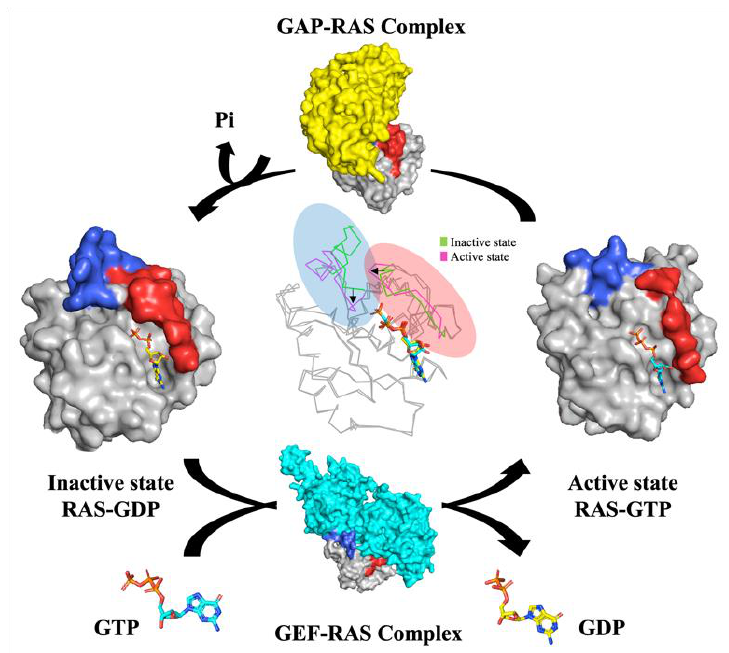
Figure 2. RAS cycles between ‘ i nactive’ state bound to GDP and ‘ a ctive’ state bound to GTP. RAS acts as a guanosine diphosphate (GDP)-inactive molecular switch in resting cells and becomes acti- vated in response to extracellular receptors by binding guanosine triphosphate (GTP), as catalyzed by the guanine nucleotide exchange factor (GEF). The GTPase-activating protein (GAP) stops the Ras signaling by switching Ras into an inactive GDP-bound signaling state. PDB IDs: 7C40 (RAS- GDP), 6Q21 (RAS-GTP), 1WQ1 (GAP-RAS), and 4G0N (GEF-RAS).